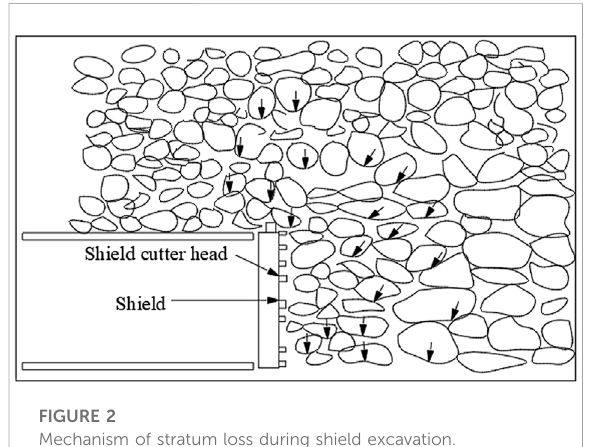
FIGURE 2 Mechanism of stratum loss during shield